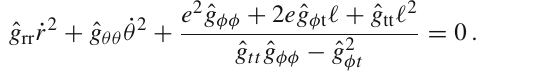
in the regular black hole spacetime. The affine parameter λ → +∞ for r → + 0, and therefore the spacetime is geodesically complete. b As in a but for a = 4 . 5. c Plot of the affine parameter λ( r ) for an infalling massless particle in the singular black hole spacetime. The affine parameter is finite when r = 1. d As in c but for a = 4 .